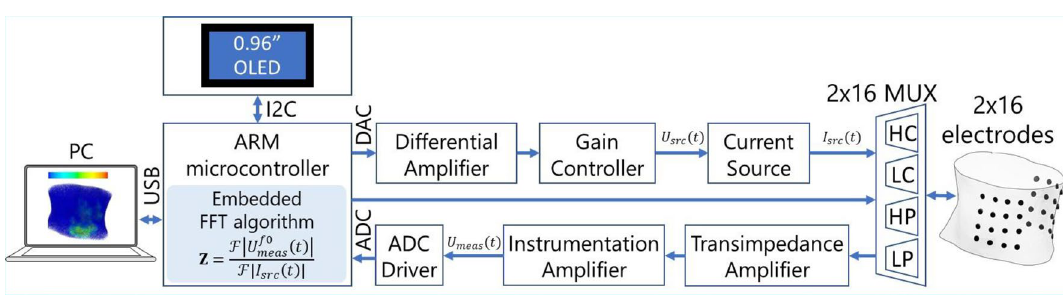
Figure 3. The block diagram of g EIT